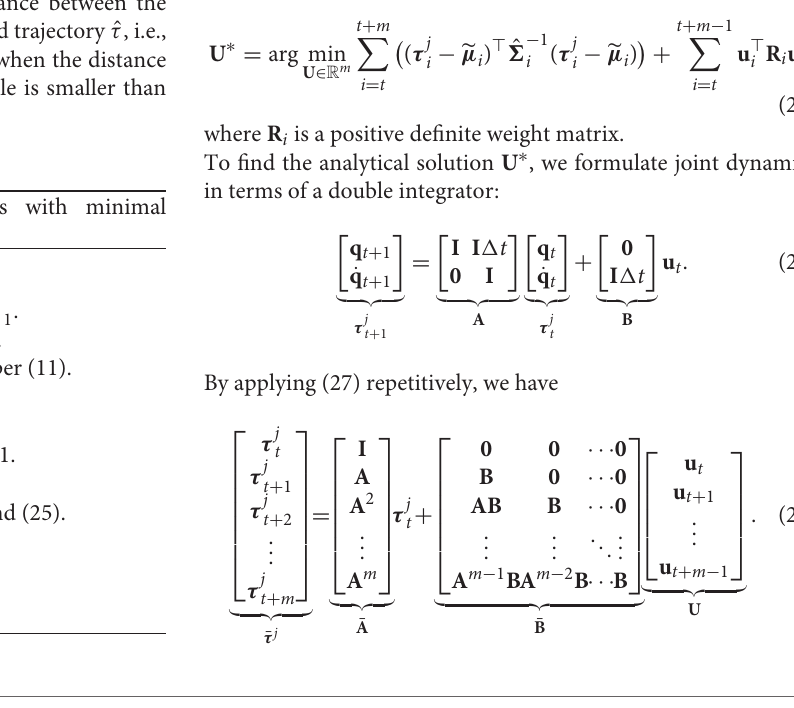
where k ( · , · ) is a kernel function; k ( s o ) = φ ( s o ) ⊤ 8 ⊤ with φ ( · )